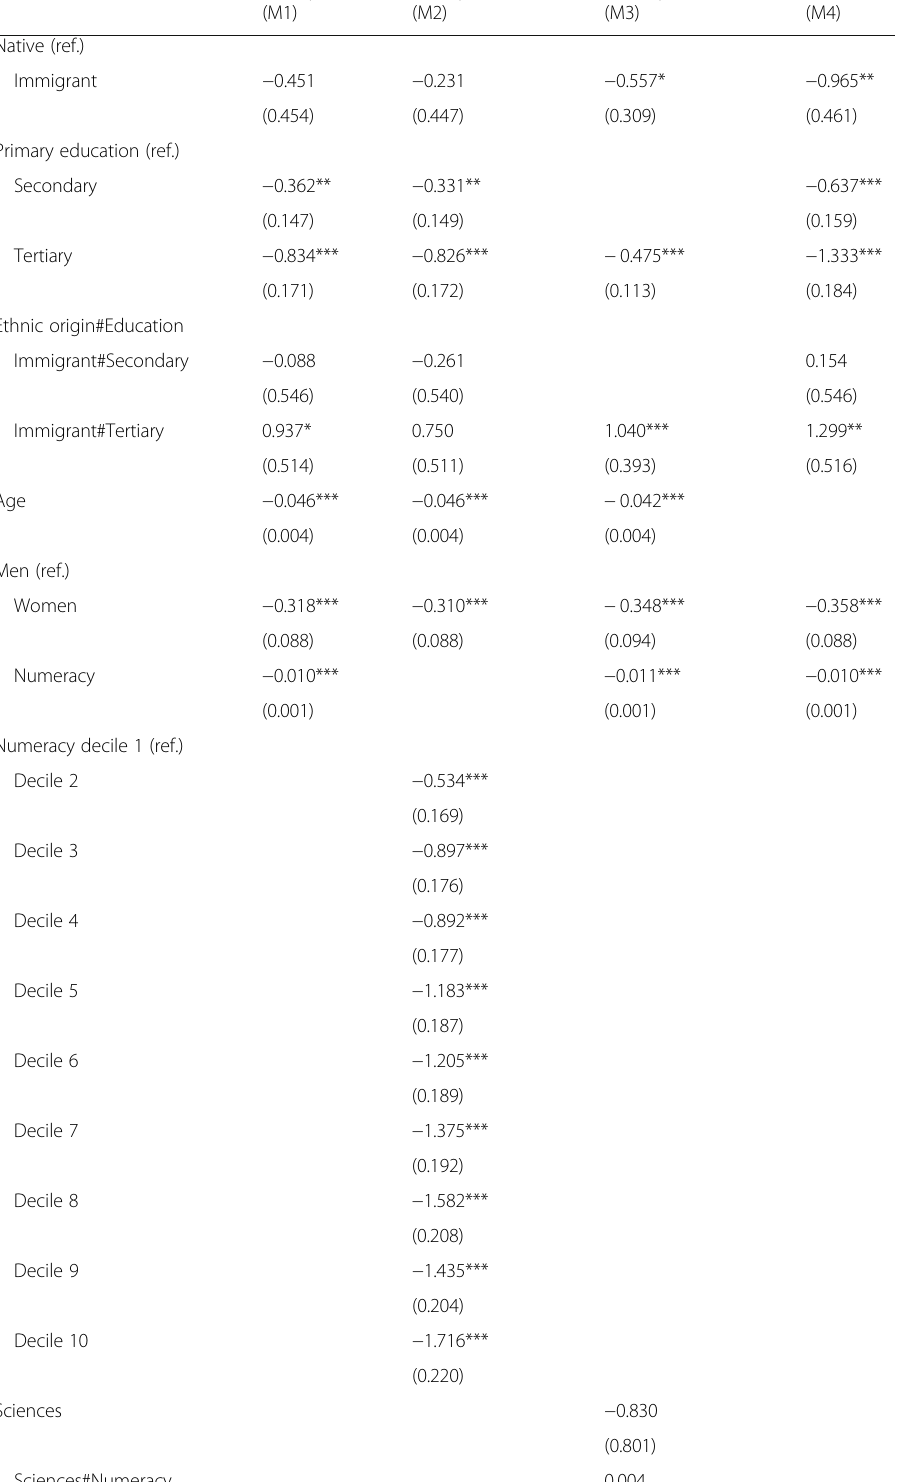
Table 6 Logistic regression on the probability of being unemployed. Explanations for the ethnic gap between natives and immigrants settled in UK